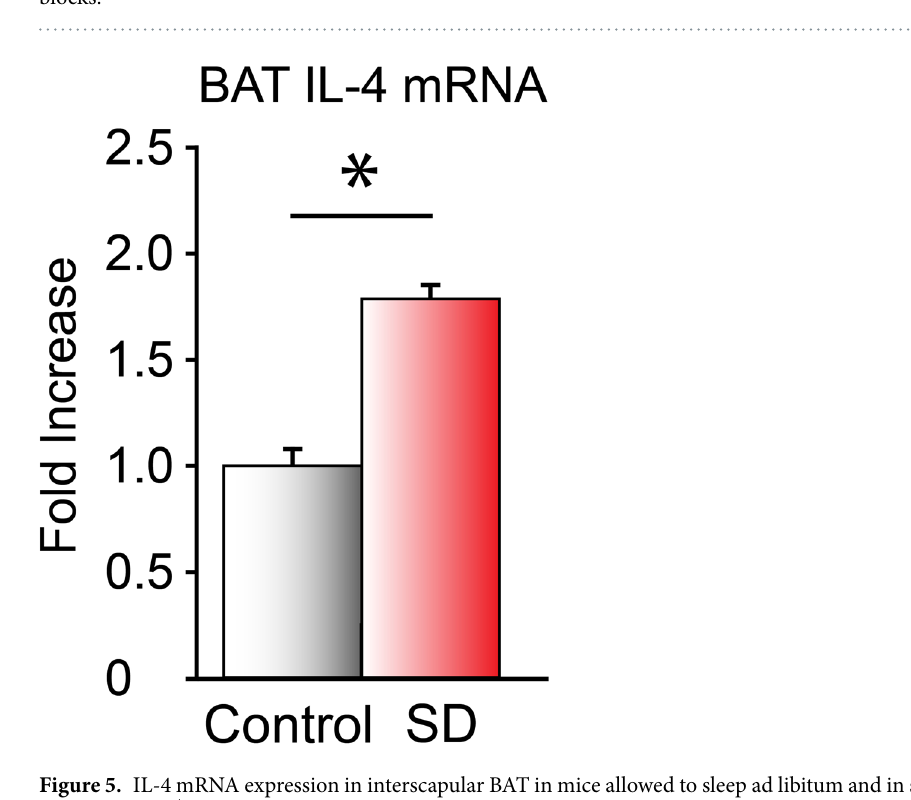
Figure 4. Changes in VO 2 during the baseline day at 30 °C ambient temperature and during the 10 °C cold exposure day in WT (white symbols) and IL-4 R α KO (red symbols) mice. Data are calculated in 2-h time blocks.